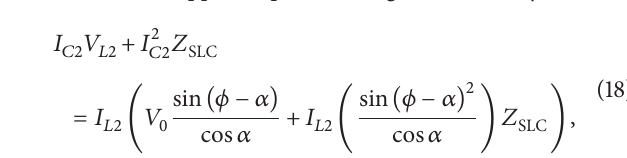
Figure 3: Fuzzy logic controller for system under